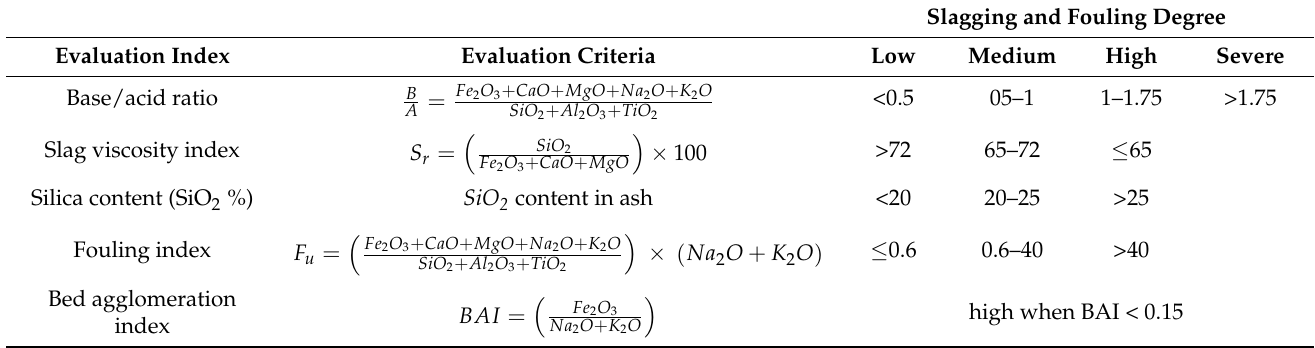
Table 1. Slagging and fouling indices to understand ash related issues